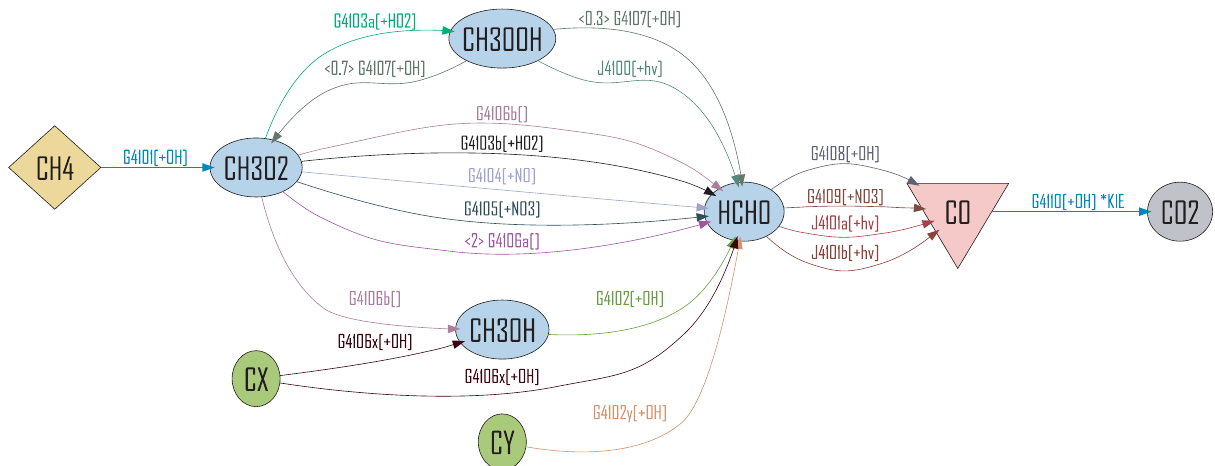
Fig. 2. Schematic representation of carbon interchanges in the prototype mechanism. Intermediates are shown in blue; methane, carbon dioxide and two artificial species (C X , C Y ) are non-transient in-situ C source species. Pathway captions refer to the internal MECCA reaction number and second